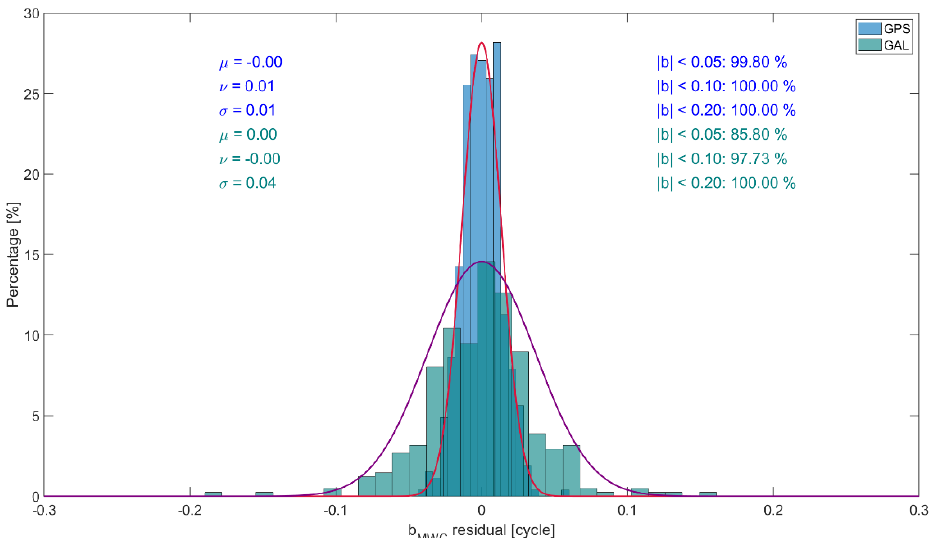
Figure 8. Distribution of the residuals of the daily ϐ MWC s estimates for GPS and GALILEO w.r.t. the overall 16 − day mean. Red and purple curves show the approximating normal distributions for GPS and GALILEO, respectively.